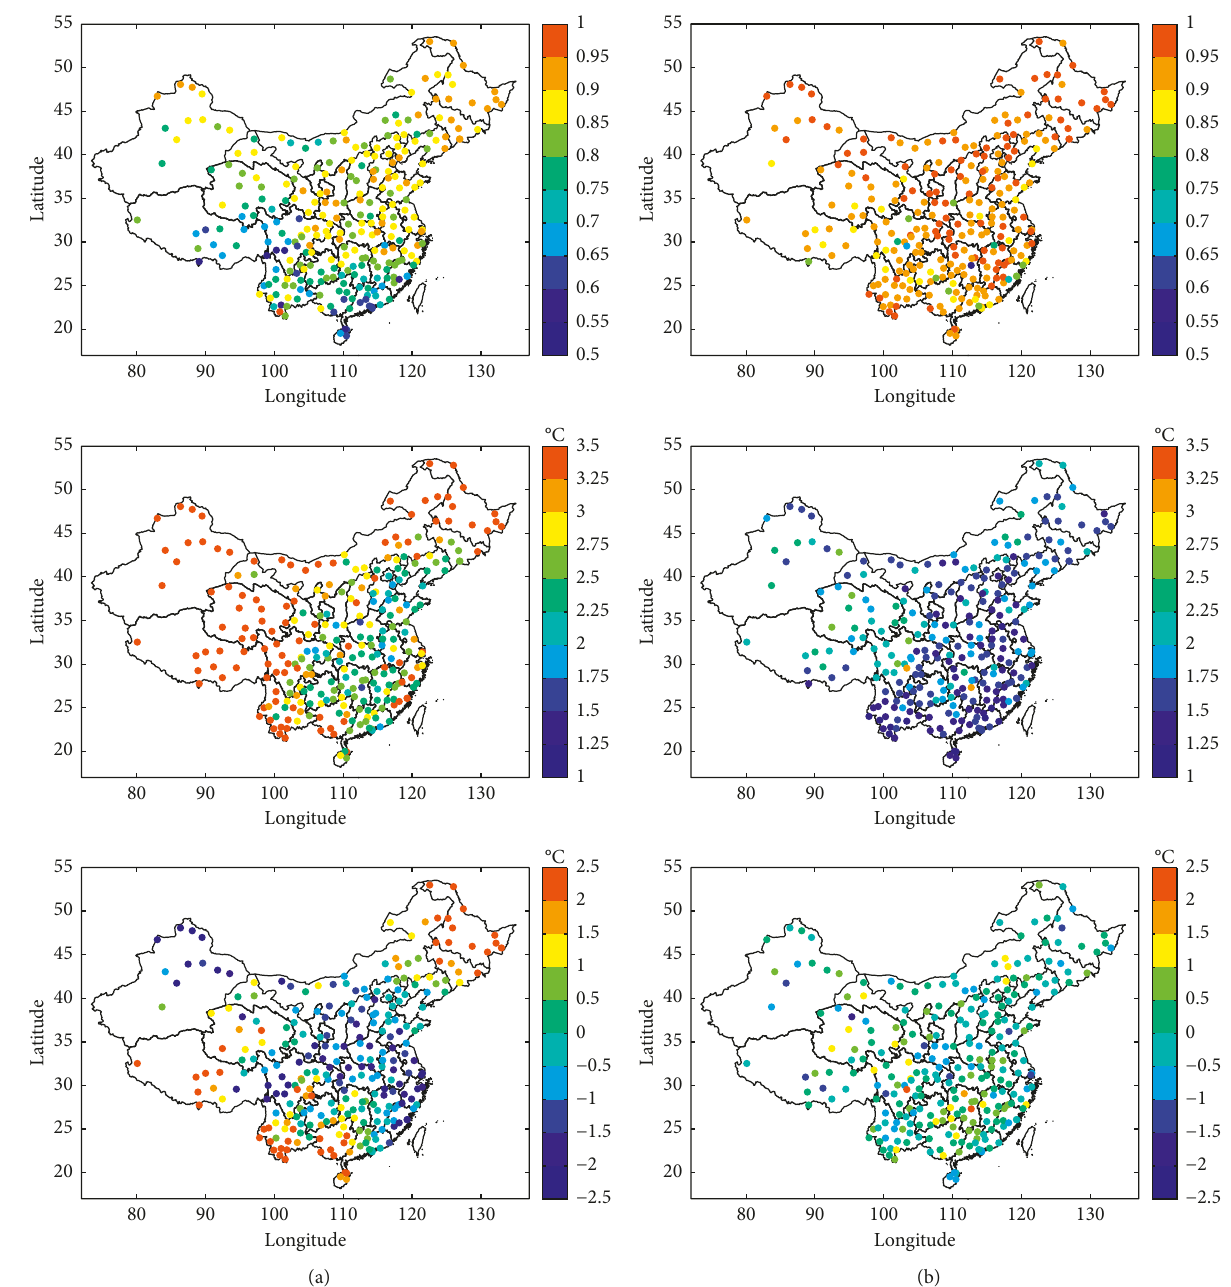
Figure 4: Spatial distribution of R (top panel), RMSE (middle panel), and bias (bottom panel) for estimated T model